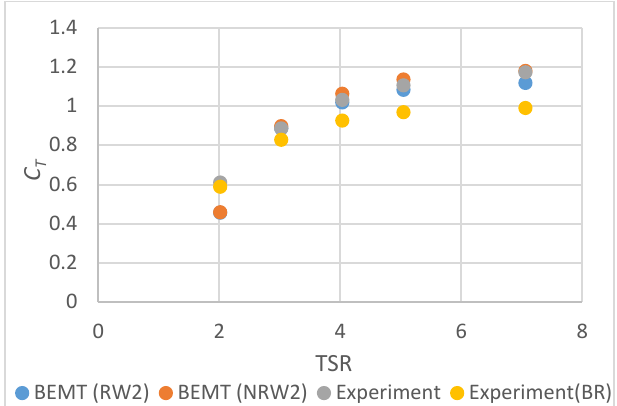
Figure 13. C T comparison between BEMT calculations and experimental data for the inflow profiles with and without a turbine when the turbine operates under wave-current interactions with a wave height of approximately 0.09m and an apparent wave period of